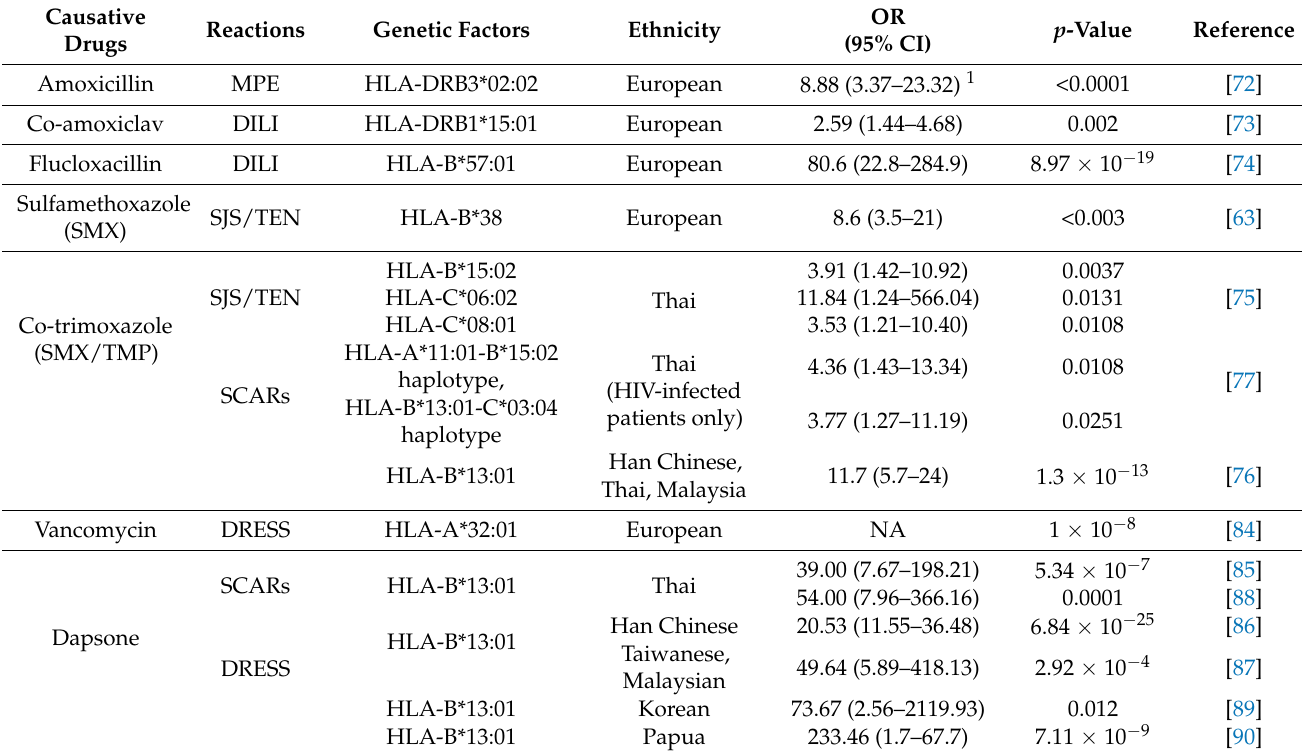
Table 4. Genetic variants associated with antibiotics-induced hypersensitivity